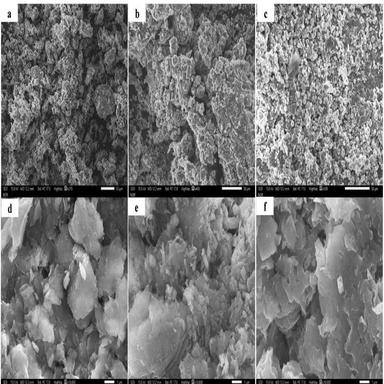
SEM images: (a) MMT K10-15.0 kV, 50 m magnification; (b) STEAM1-5.0 kV, 50 m magnification; (c) STEAM2- 15.0 kV, 50 m magnification; (d) MMT K10-15.0 kV, 1 m magnification; (e) STEAM1-15.0 kV, 1 m magnification; (f) STEAM2-15.0 kV, 1 m magnification.